Question: Sum up the contents of this chart in one sentence.
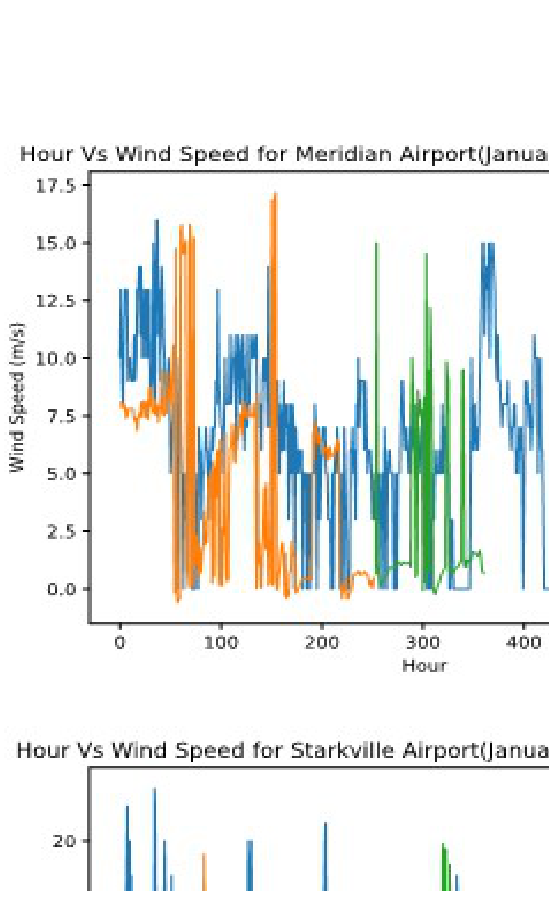
Answer: MERIDIAN VS. STARKVILLE FOR THE MONTH OF